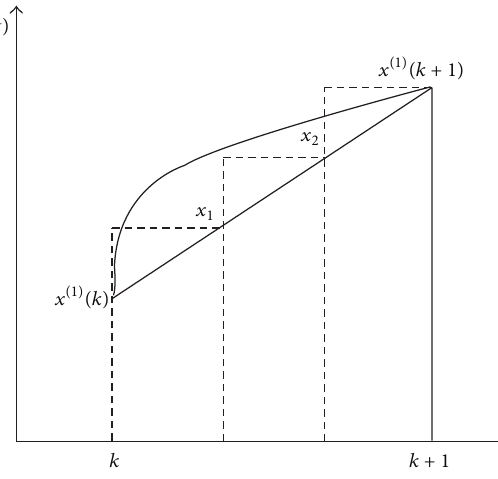
Figure 2: The convex once accumulated